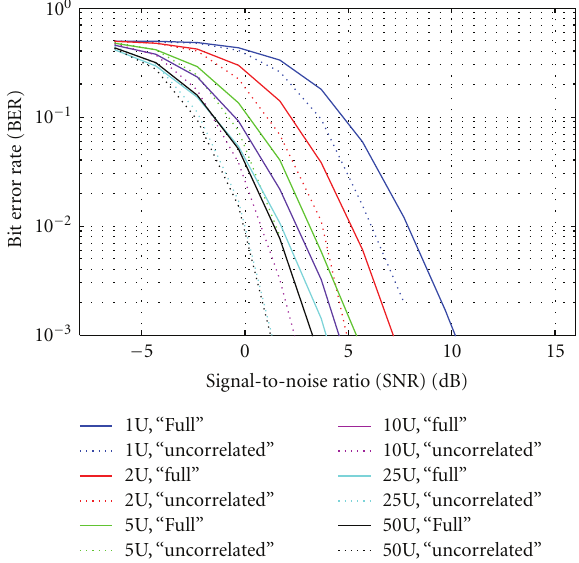
Figure 7: BER performance of an MU-MIMO (full feedback) with di ff erent number of